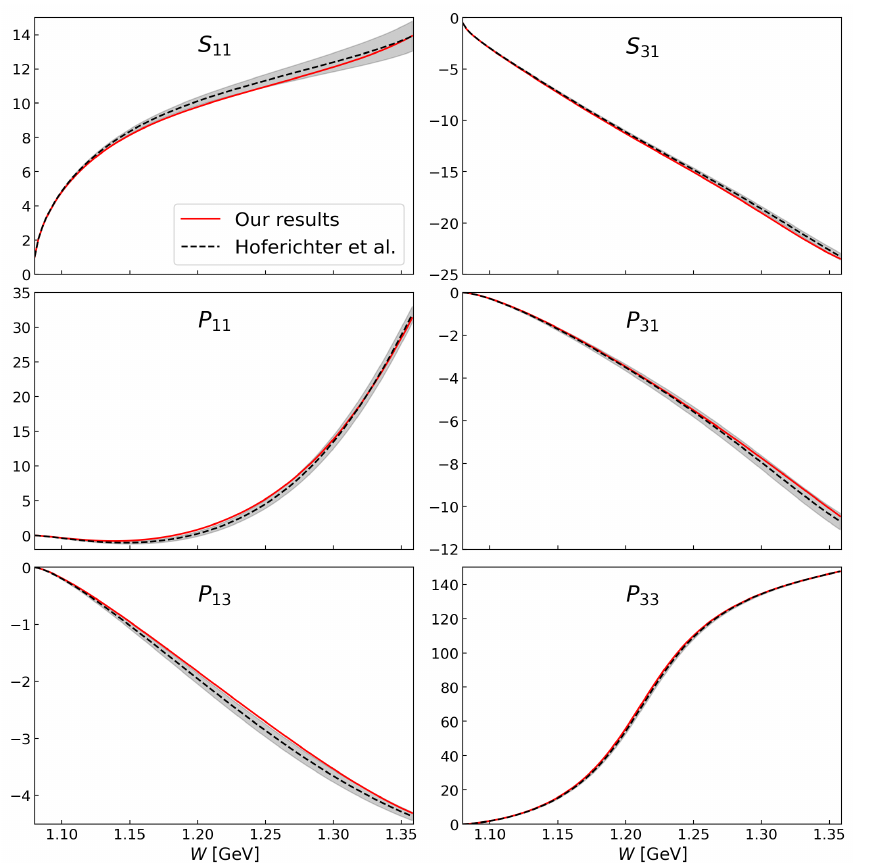
Figure 3 . Phase shifts of the s -channel PW s from our solutions (solid line) and [18] (dashed line with error bands) in the low-energy